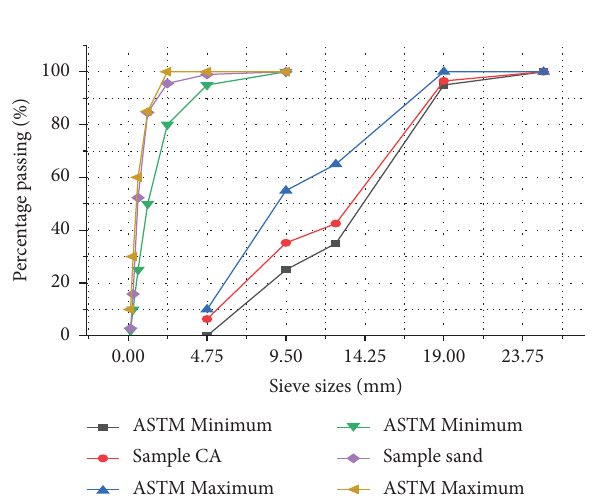
Figure 1: Particle size distribution curve of sand and coarse ag- gregate